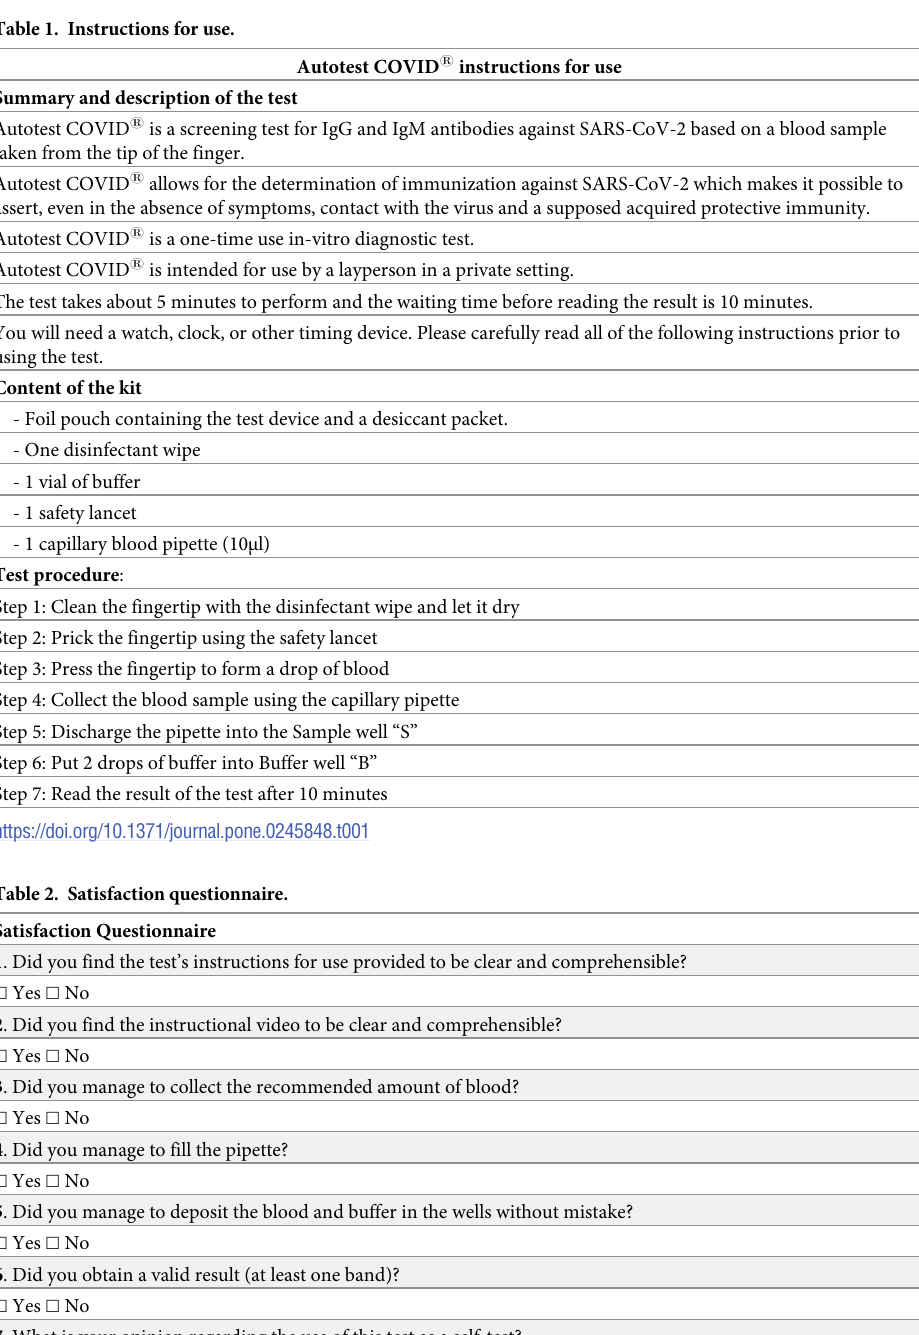
Table 1. Instructions for use. Summary and description of the